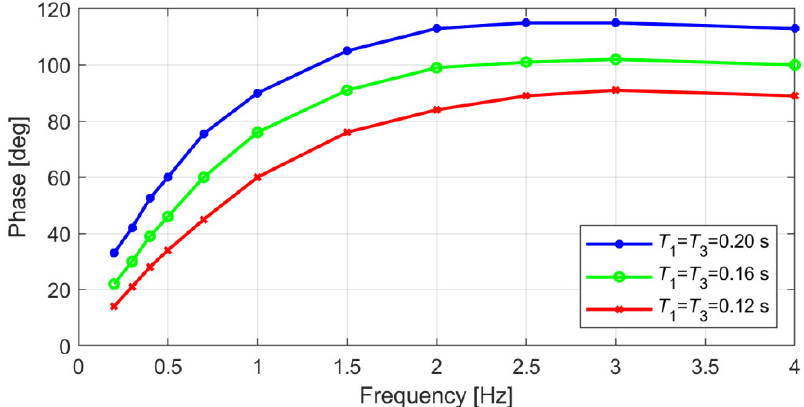
Figure 5. Examples of the PSS2A’s phase-compensation characteristics ( T 2 = T 4 = 0.02 s, T 1 = T 3 = 0.20 s/0.16 s/0.12